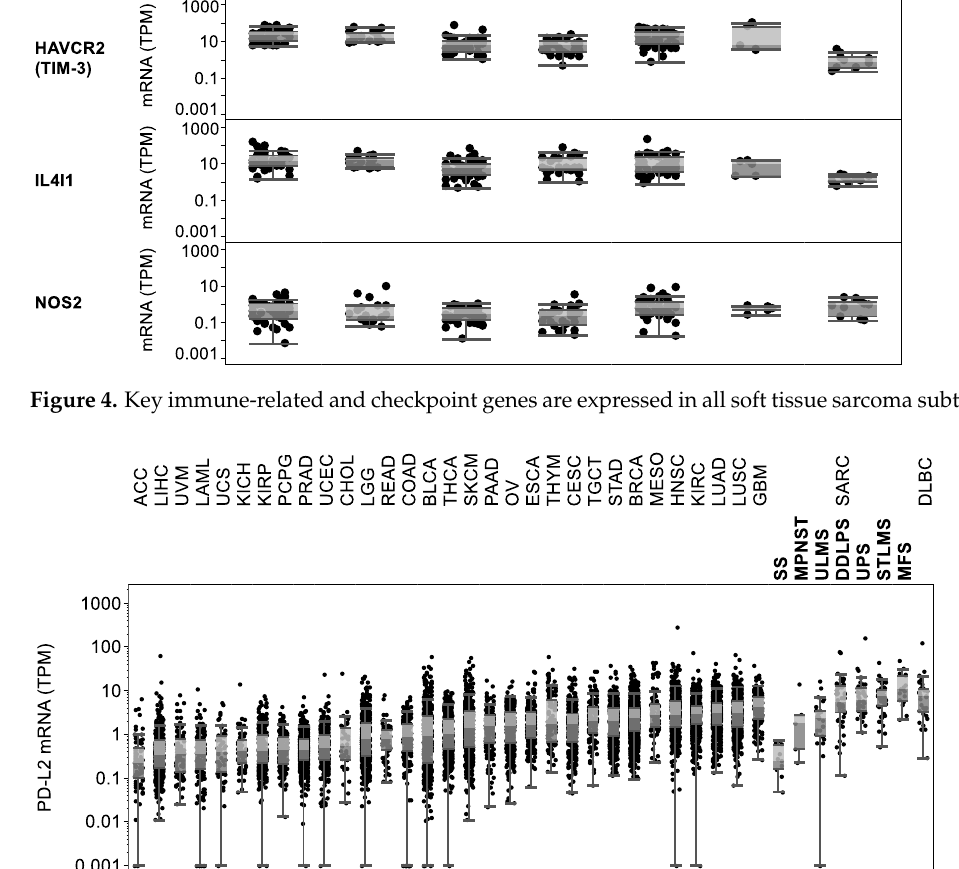
Figure 5. PD-L2 expression levels are high in soft tissue sarcomas. Tumor types and subtypes are sorted by median PD-L2 expression levels. sorted by median PD-L2 expression